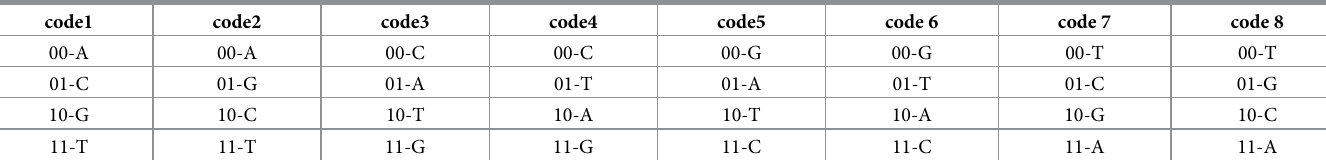
Table 2. DNA coding